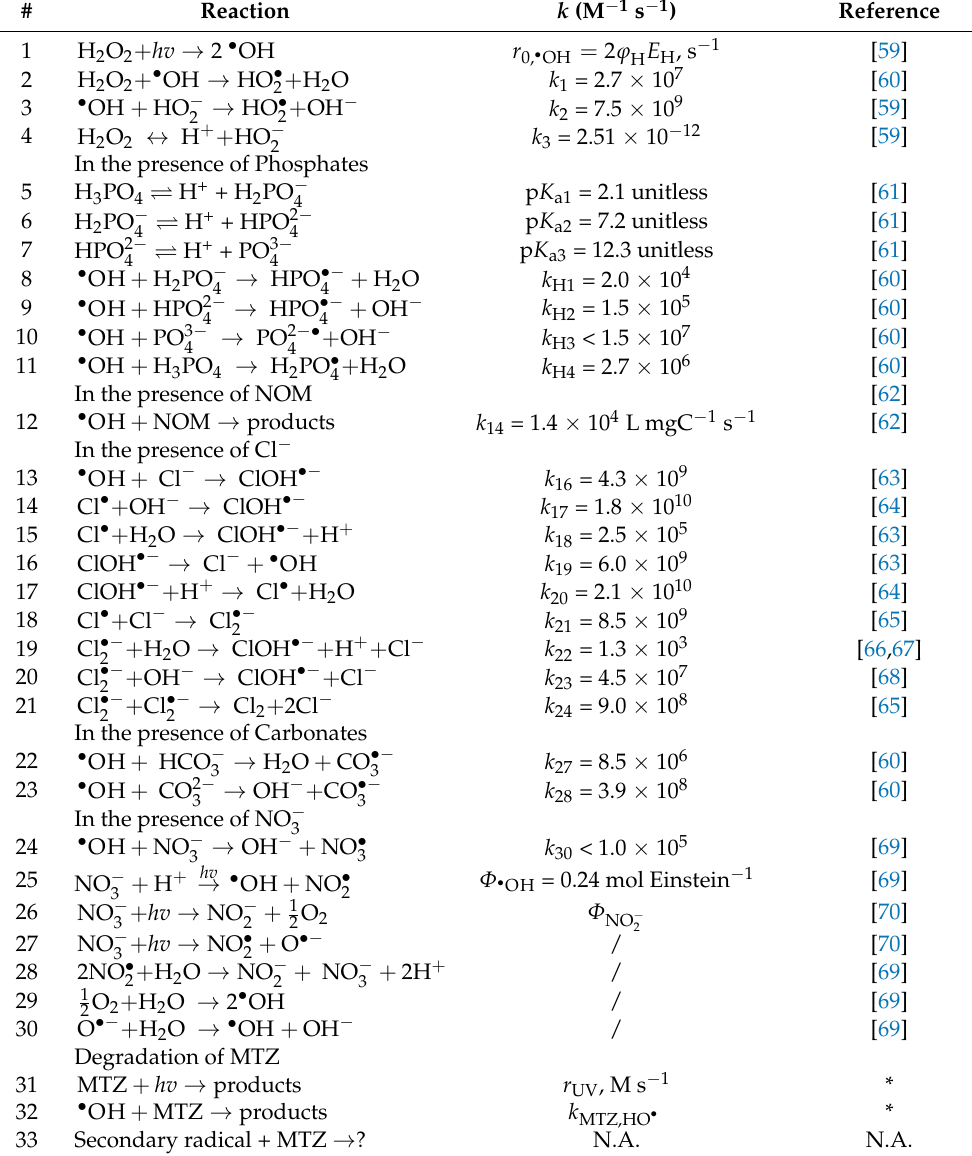
Table 2. Summary of the reactions and k in the UV/H 2 O 2